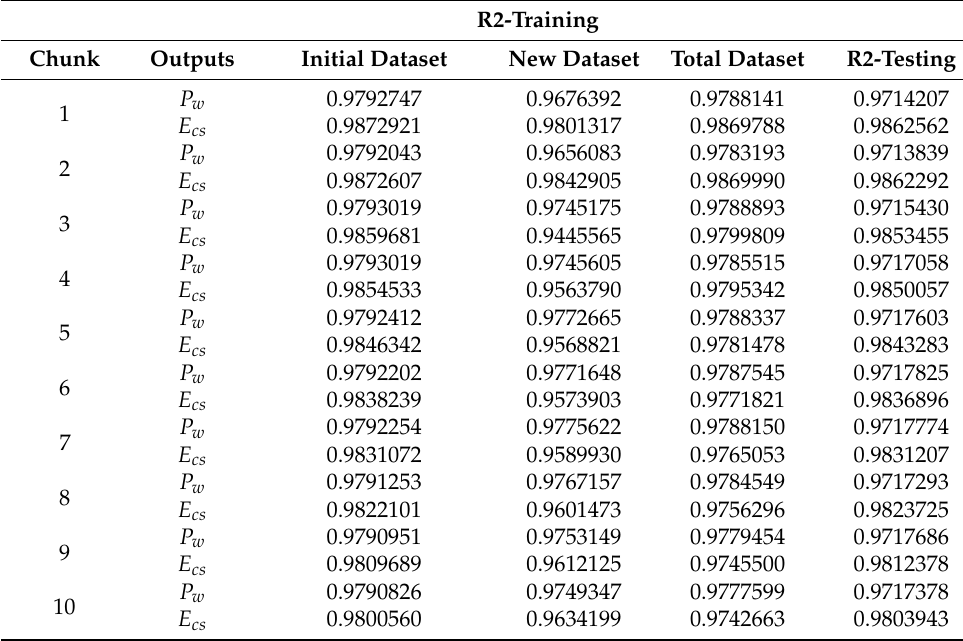
Table 6. Online sequential training of ELM, SAG